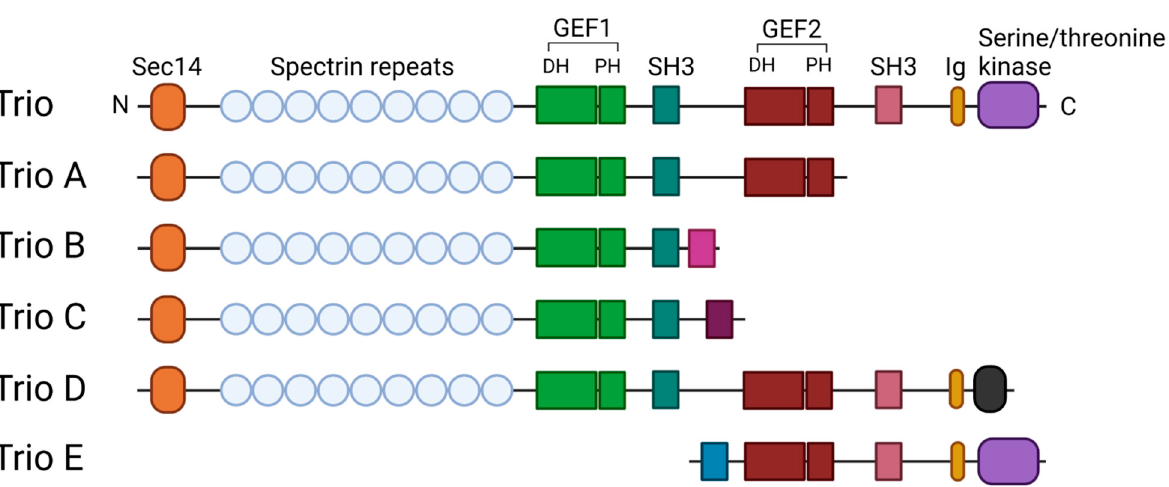
Figure 1. Schematic representation of Trio isoforms. The full-length Trio contains a Sec14 domain, several Spectrin repeats, two GEF domains, two S SRC Homology 3 Domains (SH3) and a serine/threonine kinase domain. Other isoforms arise due to alternative splicing and contain a mix of these domains. The pink, purple and turquoise box represent specific amino acids unique to the isoform. The figure was created with BioRender.